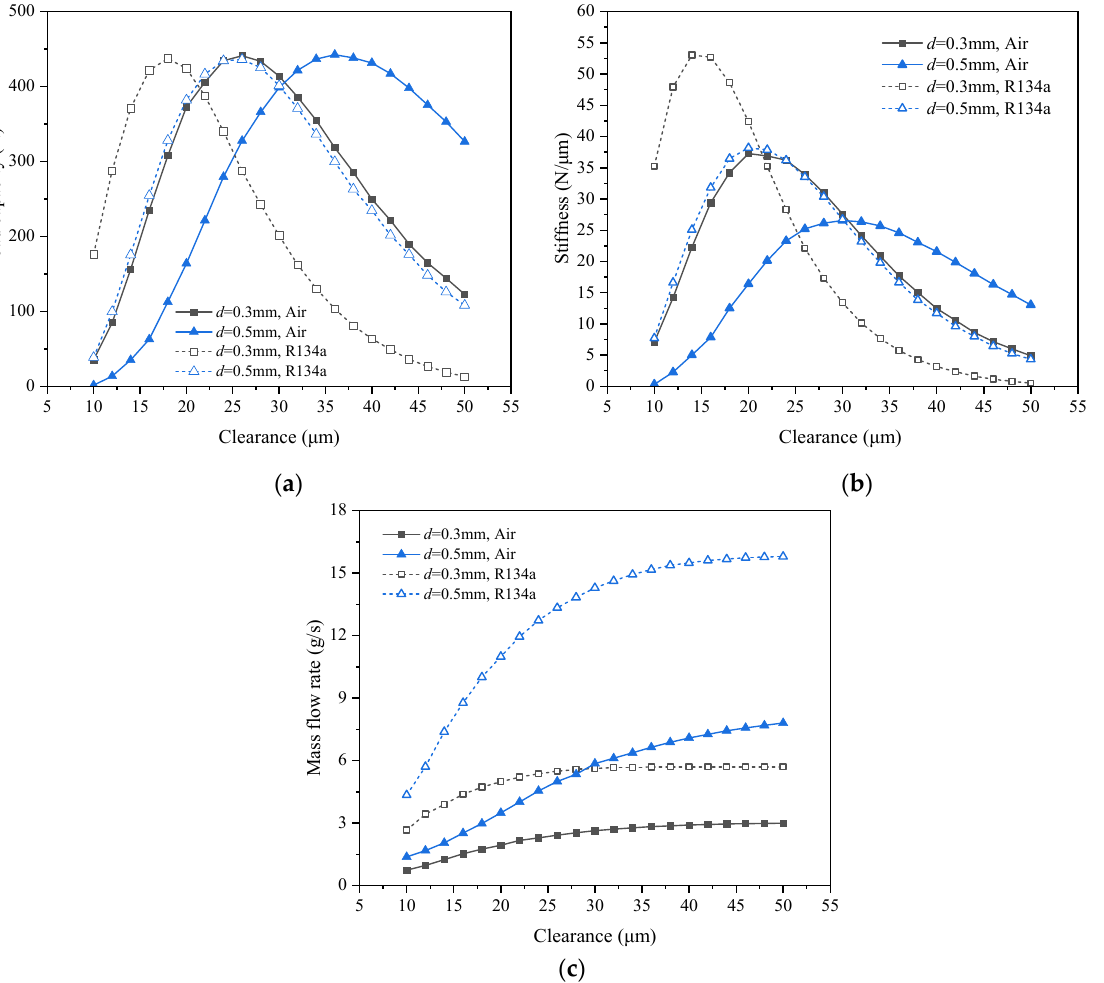
Figure 6. Effect of average clearance under different orifice diameters ( ε = 0.5, p s = 0.95 MPa) ( a ) on load capacity ( b ) on stiffness ( c ) on mass flow rate.